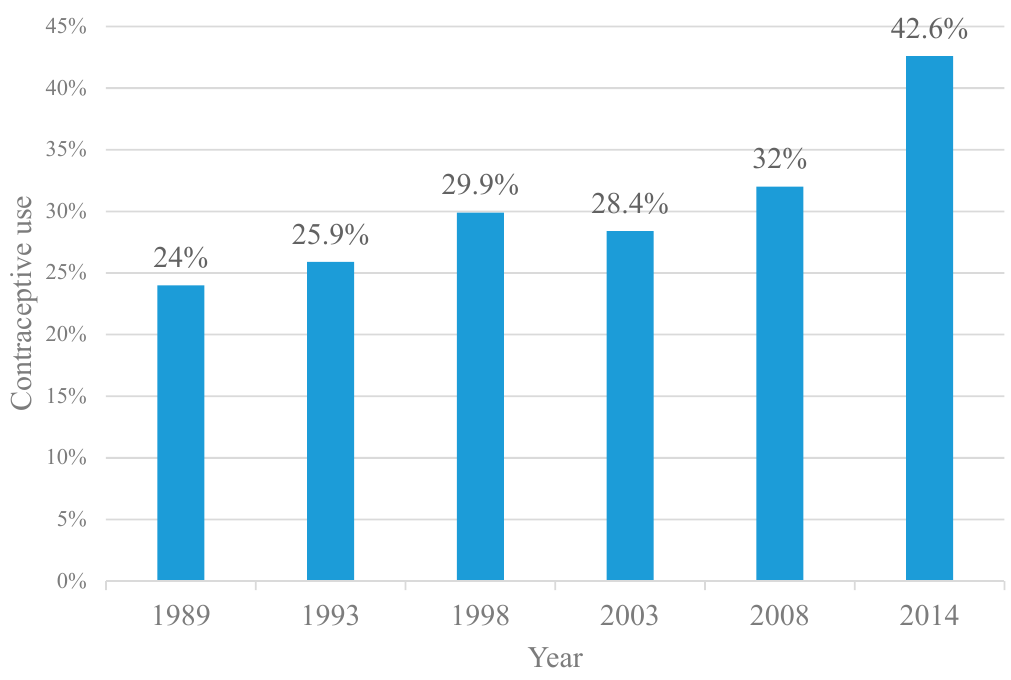
Figure 1. Contraceptive Use, Kenya, 1989–2014.